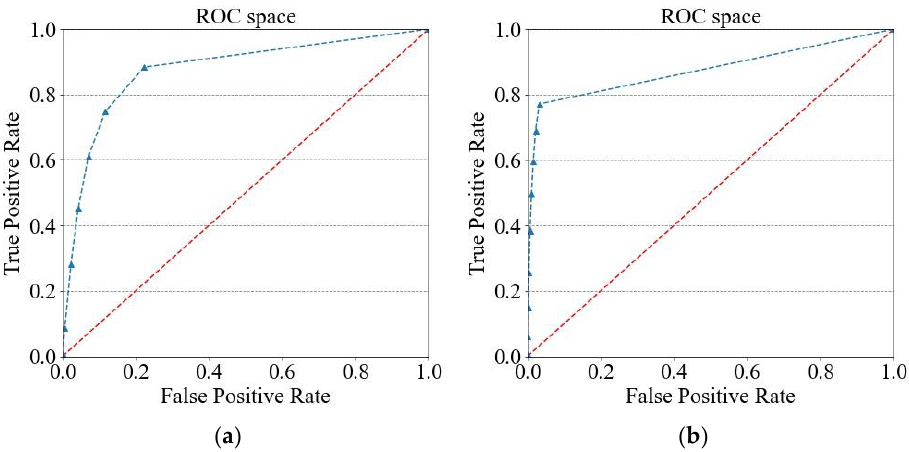
Figure 10. ROC curves generated from predicted settlement growth probability maps of HCMC and Abidjan. Results were generated from STM-based model, implemented with the MLP and the ten-year strategy. ( a ) ROC curve of HCMC, ( b ) ROC curve of Abidjan. Table 3. Statistical results of ROC curves from HCMC and Abidjan.